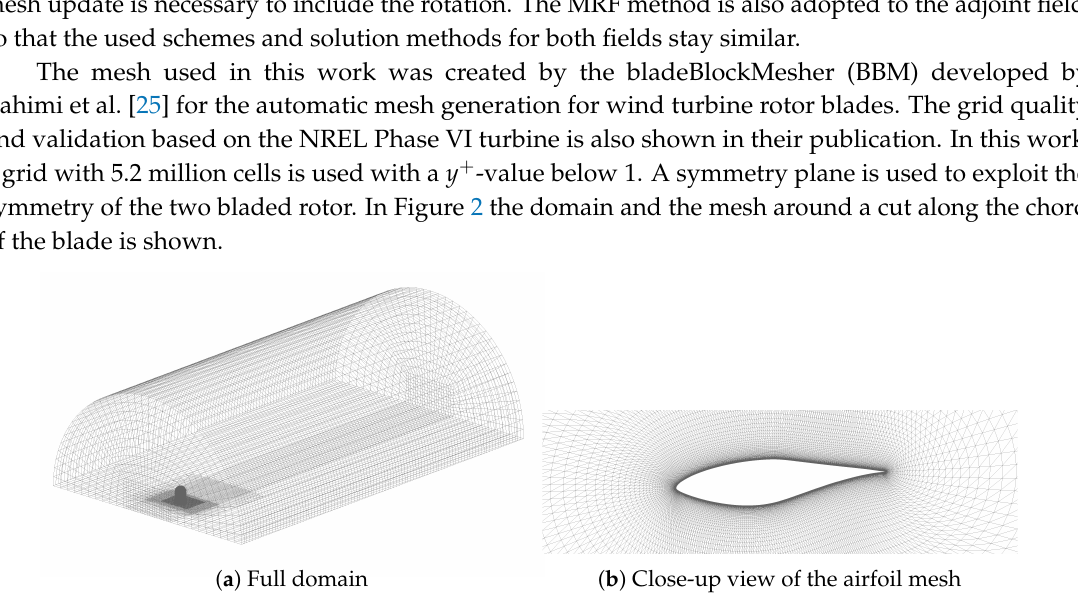
Figure 2. Numerical grid. The flow is coming from the left in ( a ). In ( b ), the o-type mesh around a cut through the blade is